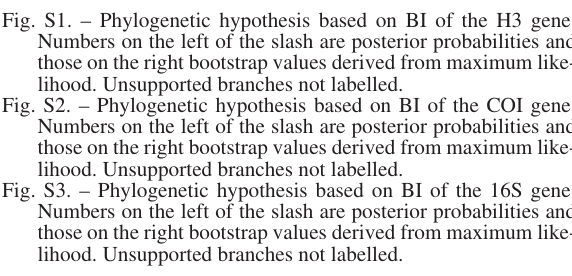
Fig. S1. – Phylogenetic hypothesis based on BI of the H3 gene. Numbers on the left of the slash are posterior probabilities and those on the right bootstrap values derived from maximum like- lihood. Unsupported branches not labelled. Fig. S2. – Phylogenetic hypothesis based on BI of the COI gene. Numbers on the left of the slash are posterior probabilities and those on the right bootstrap values derived from maximum like- lihood. Unsupported branches not labelled. Fig. S3. – Phylogenetic hypothesis based on BI of the 16S gene. Numbers on the left of the slash are posterior probabilities and those on the right bootstrap values derived from maximum like- lihood. Unsupported branches not